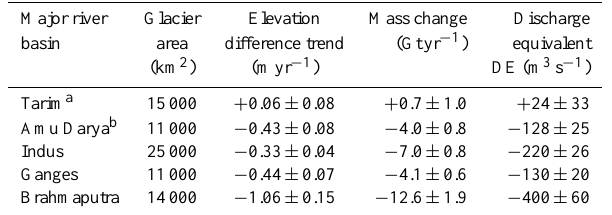
Table 2. Glacier thickness and mass changes over the major river basins of the study area. The discharge equivalent is a unit conver- sion from mass change and neglects any losses such as by evapora- tion or to